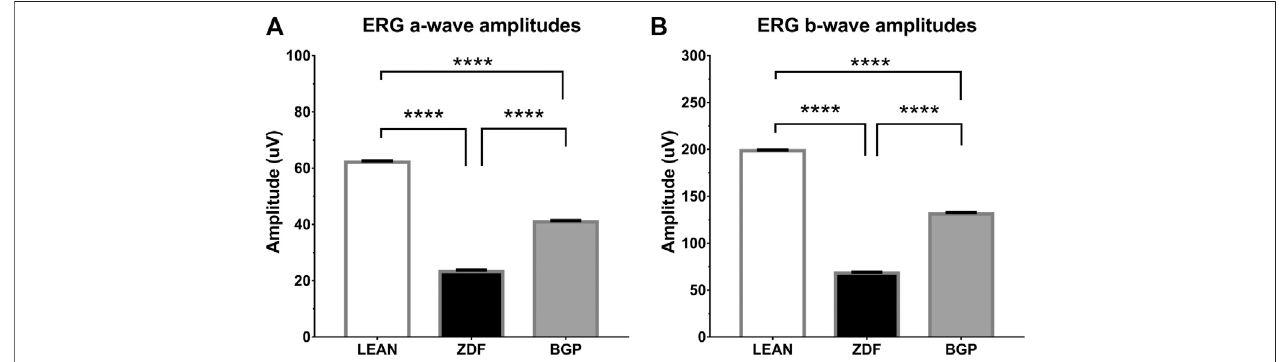
FIGURE 5 | Results of electroretinography (ERG) measurements. (A) Group means of a-waves; (B) Group means of b-waves. All data are presented as group means ± standard error of the mean (SEM). **** p < 0.0001 Statistical analysis was done using GraphPad Prism: after estimation of Gaussian distribution with the Shapiro – Wilk normality test, data were either analyzed with the one-way analysis of variance (ANOVA) or the nonparametric Kruskal – Wallis test.